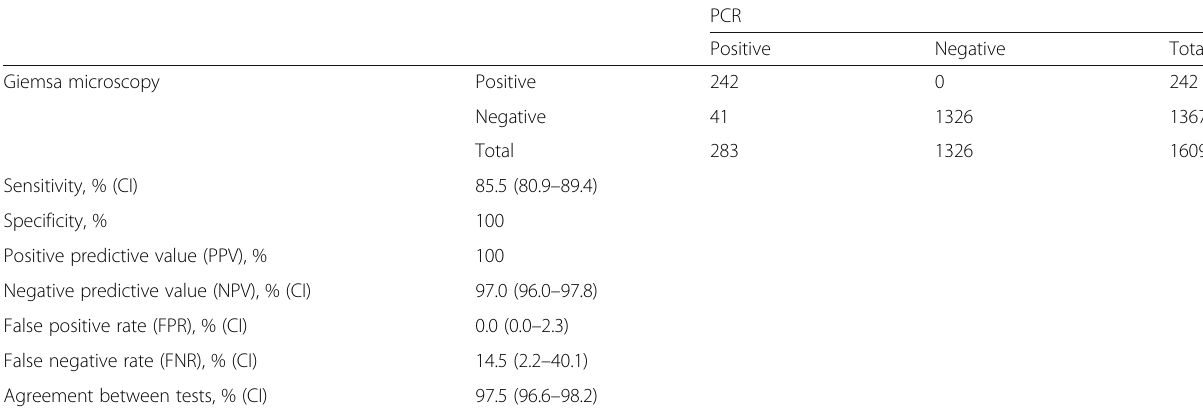
Table 2 The performance of Giemsa microscopy (GM) in comparison to PCR in the detection of malaria parasites in the study population